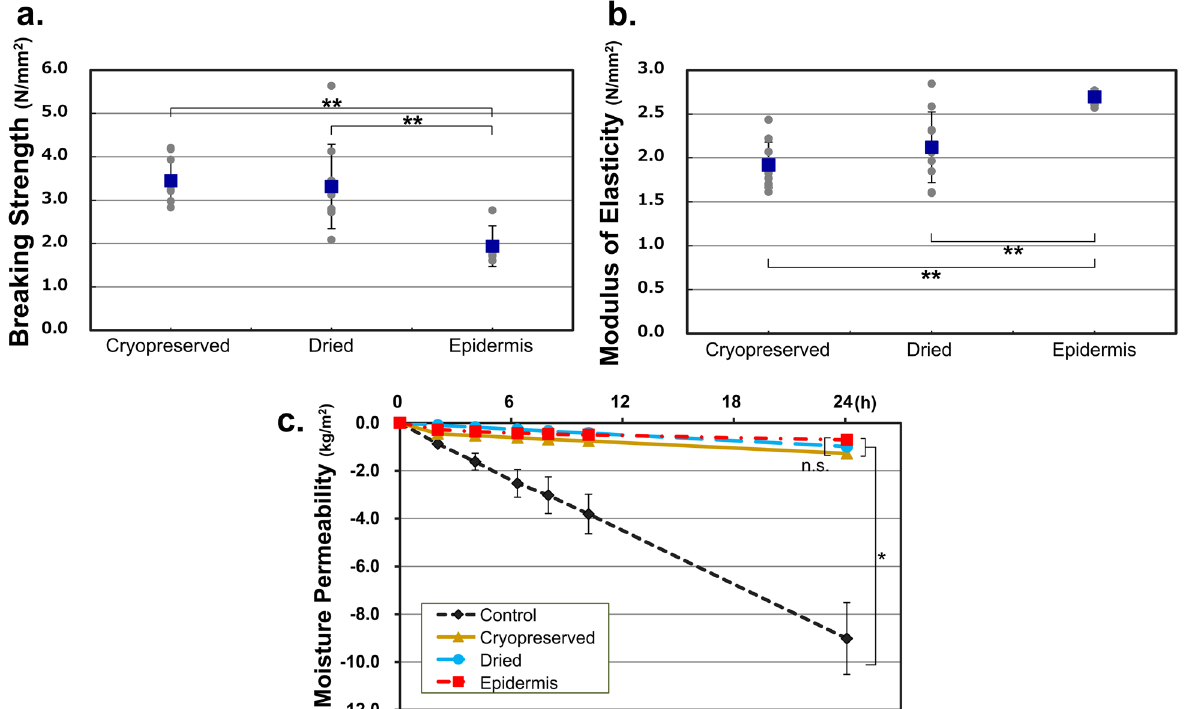
Figure 2. Mechanical properties of a dried CE. ( a ) Breaking strength of cryopreserved CE, dried CE, and epidermis. The breaking strengths of the cryopreserved and dried CEs did not differ significantly (n = 5). ( b ) Modulus of elasticity of cryopreserved CE, dried CE, and epidermis. The modulus of elasticity of the cryopreserved CE and dried CE did not differ significantly (n = 5). ( c ) Moisture permeability of cryopreserved CE, dried CE, and epidermis. A significant difference was not observed between the moisture permeabilities of cryopreserved CE and dried CE (n = 5). The control group represents the evaporation of the saline solution in an uncovered centrifuge tube. CE, cultured